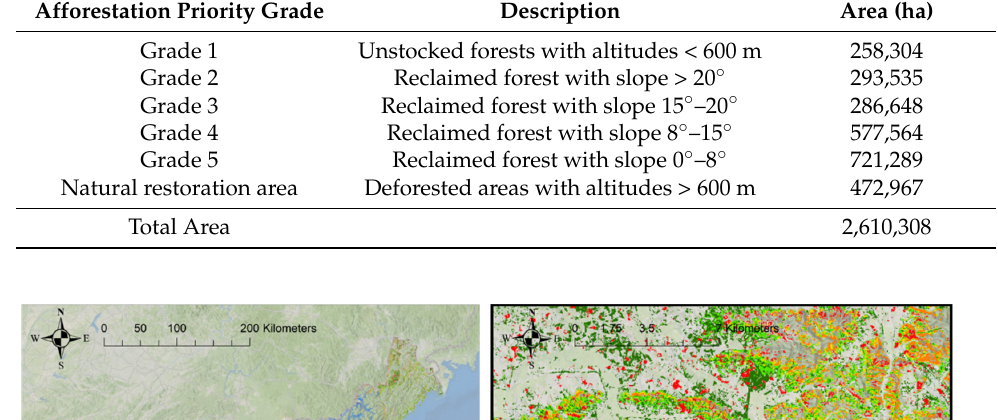
Table 5. Afforestation priority grade.